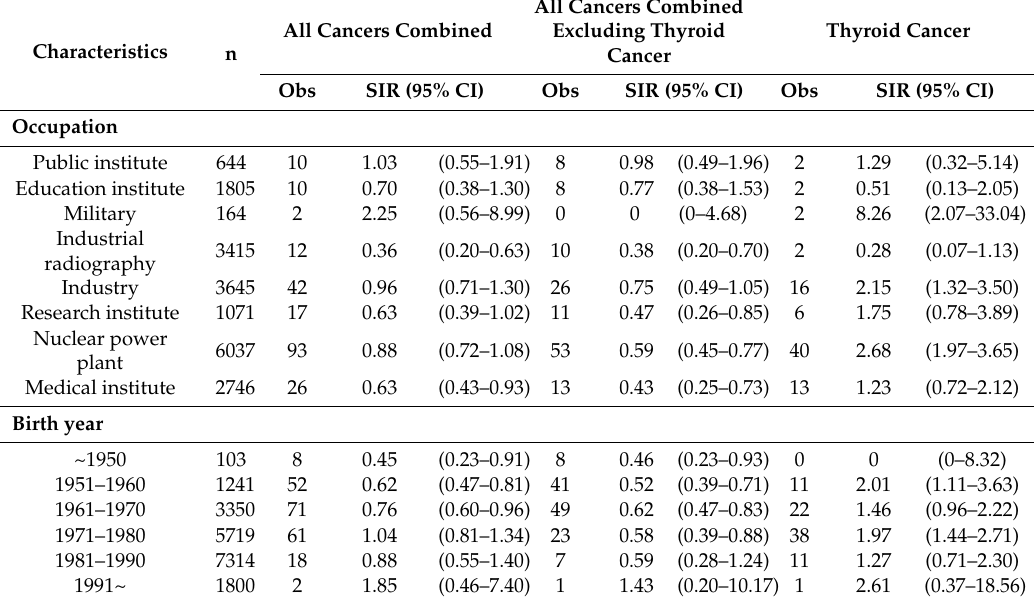
Table 5. The SIR and 95% CI for all cancers, thyroid cancer, and all cancers excluding thyroid cancer stratified by occupation and birth year.